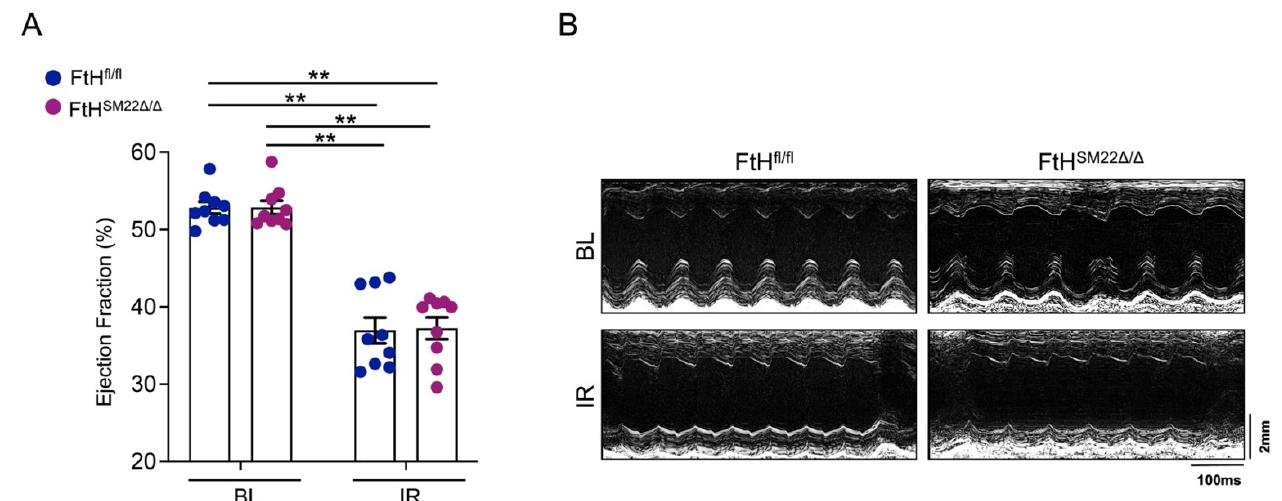
Figure 4. Functional significance of myocardial FtH deletion in IR on day one post IR. ( A , B ) FtH fl/fl and FtH SM22 Δ / Δ mice were subjected to myocardial IR (45 min via ligation of the left anterior descending coronary artery) and left ventricular ejection fraction was measured using 2D tracing in the parasternal long-axis views. ( A ) Demonstration of ejection fraction % from FtH fl/fl and FtH SM22 Δ / Δ mice under BL conditions and at 24 h post reperfusion. Data are presented as means ± SEM. n = 10/condition/genotype. ** p < 0.01. ( B ) Representative echocardiograms measured at BL and IR conditions.